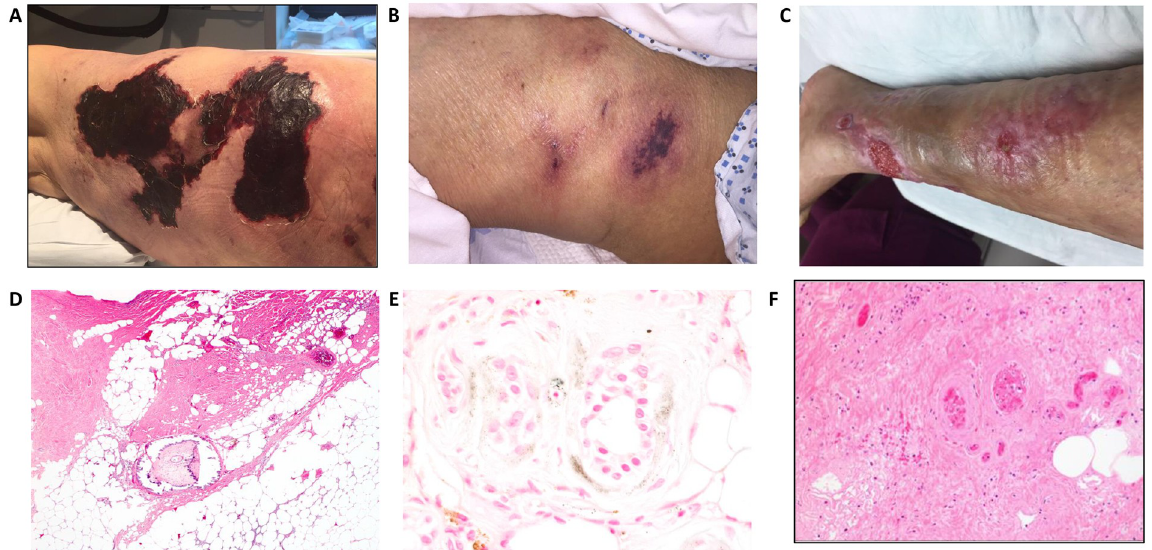
Fig 2. Representative images of skin lesions with various clinical and histological features. (A): Clinical image of an ulcer with black eschar and irregular violaceous border and surrounding erythema. (B): Non-ulcerated calciphylaxis lesions with plaque morphology and surrounding retiform purpura. (C): Erythematous lesions of calciphylaxis. (D): Histopathology of cutaneous calciphylaxis demonstrating ulceration, marked dermal necrosis, fibrointimal hyperplasia of a calcified medium sized vessel and subcutaneous fat necrosis with foci of acute inflammation (hematoxylin & eosin, 40x original magnification). (E): A von Kossa stain reveals presence of stippled peri-eccrine calcification (von Kossa stain, 600x original magnification). Panel F: Intravascular thrombosis in the deep dermis (hematoxylin & eosin stain, 200x original magnification).